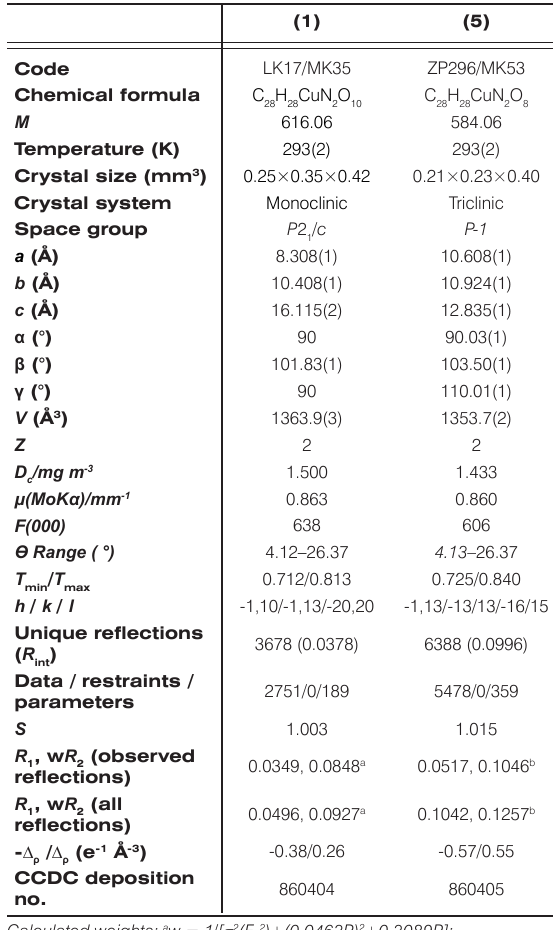
Table 1. Crystallographic data for compounds 1 and 5